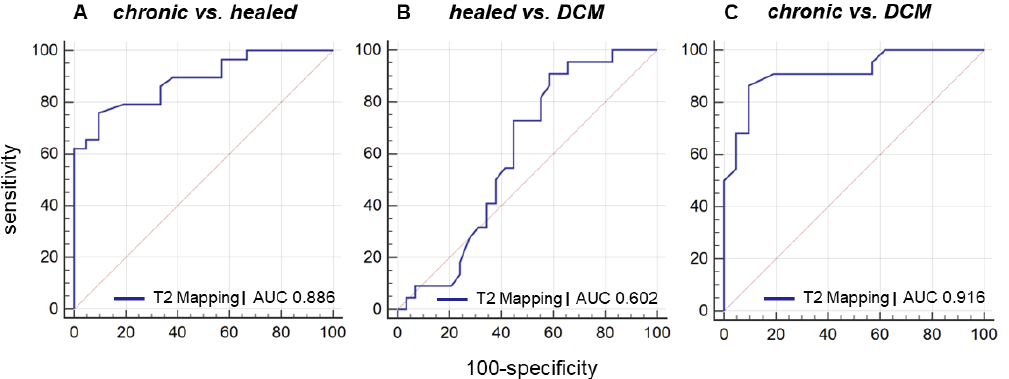
Figure 5. ROC curve for discrimination of chronic myocarditis from healed myocarditis and DCM using T2 mapping. Receiver operating characteristic (ROC) curve for discrimination of chronic myocarditis from healed myocarditis and DCM using T2 mapping shows ( A ) an area under the curve (AUC) of 0.886 (sensitivity 90%, specificity 76%) with an associated criterion >51 ms in the discrimination of chronic vs. healed myocarditis ( p < 0.0001), ( B ) an AUC of 0.602 in the discrimination of healed myocarditis vs. DCM (not significant), ( C ) and an AUC of 0.916 (sensitivity 86%, specificity 91%) with an associated criterion >52 ms in the discrimination of chronic myocarditis vs. DCM ( p < 0.0001).